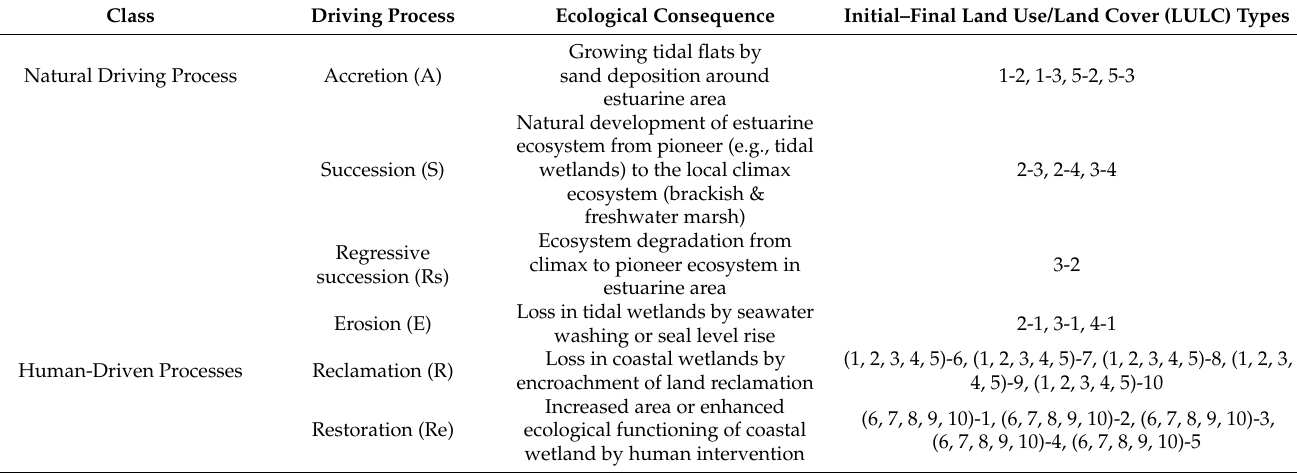
Table 2. Driving processes and the initial–final land use/land cover types in the Shanghai coastal